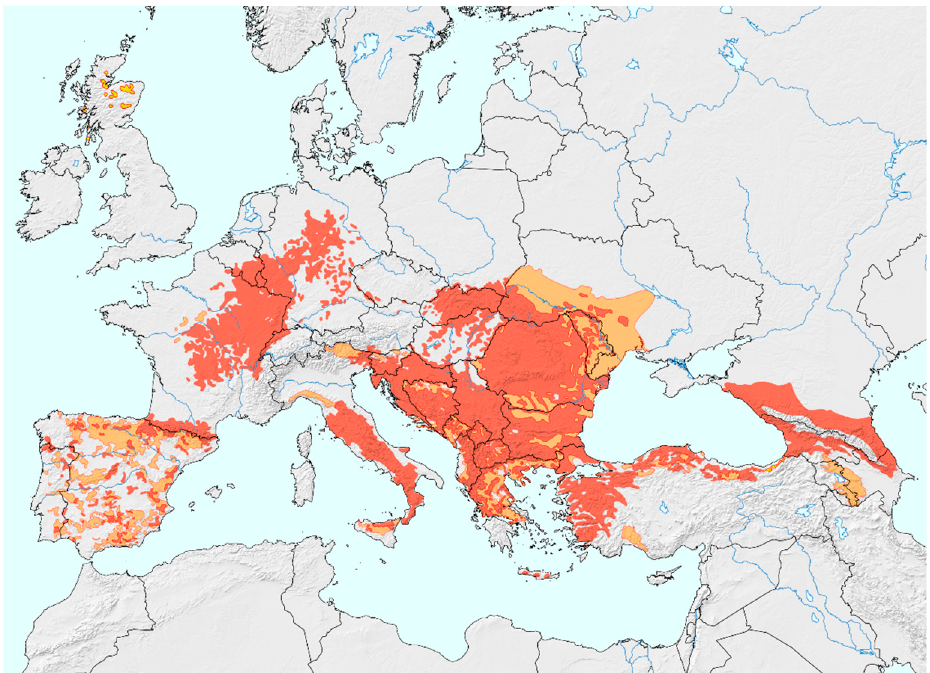
Figure 1. Current distribution of the European wildcat ( Felis silvestris ). Coloured areas: red = present, orange = possibly present, yellow = possibly extinct. Used after permission by Peter Gerngross [1].